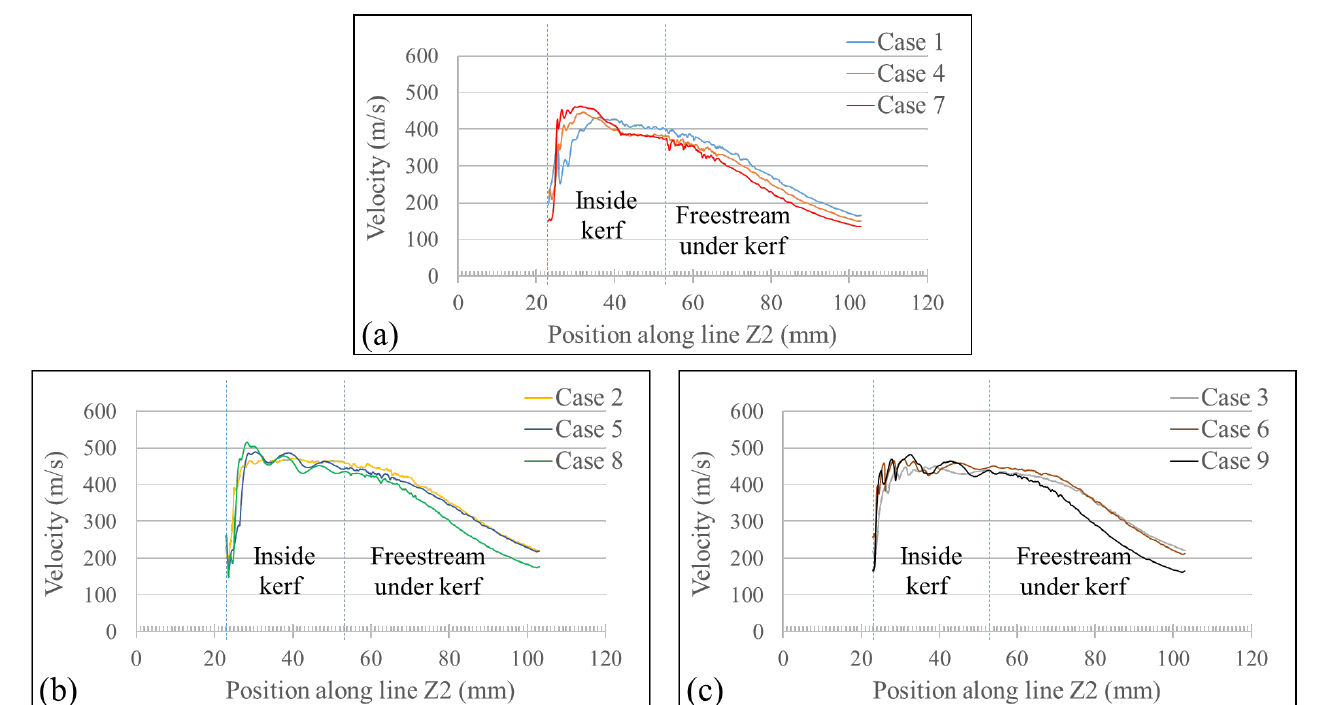
Figure 19. Velocity distribution curve along line Z2 for various kerf geometry: ( a ) cases 1, 4 and 7; ( b ) cases 2, 5 and 8; and ( c ) case 3, 6 and 9.